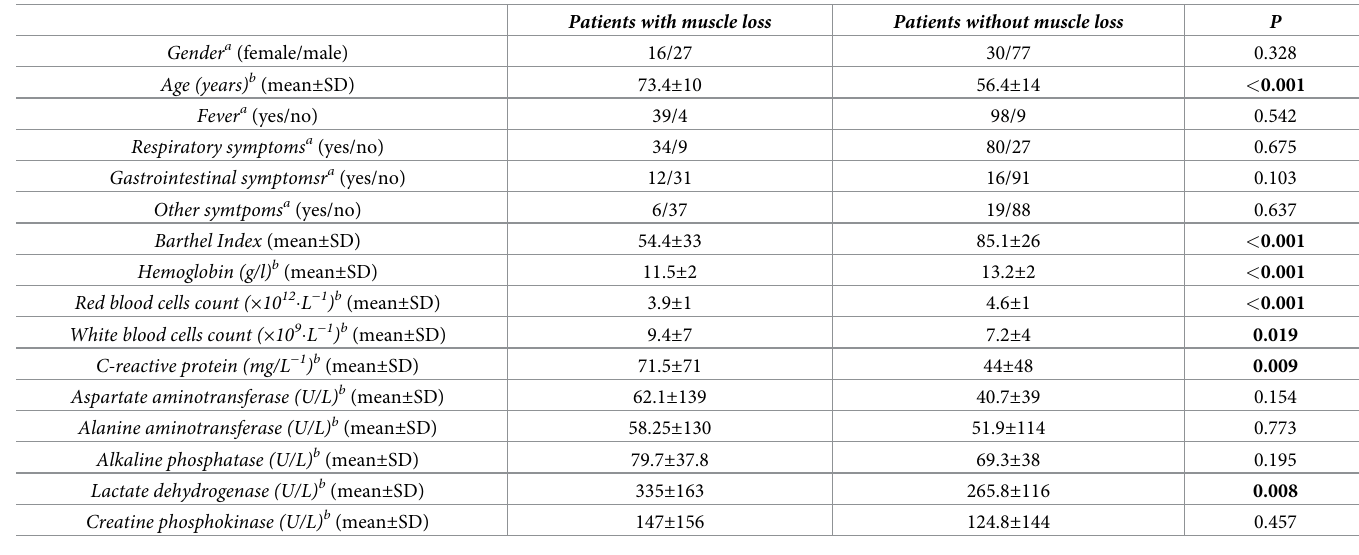
Table 1. Comparison of demographics, clinical, and laboratory findings between COVID-19 patients with and without muscle loss. Patients with muscle